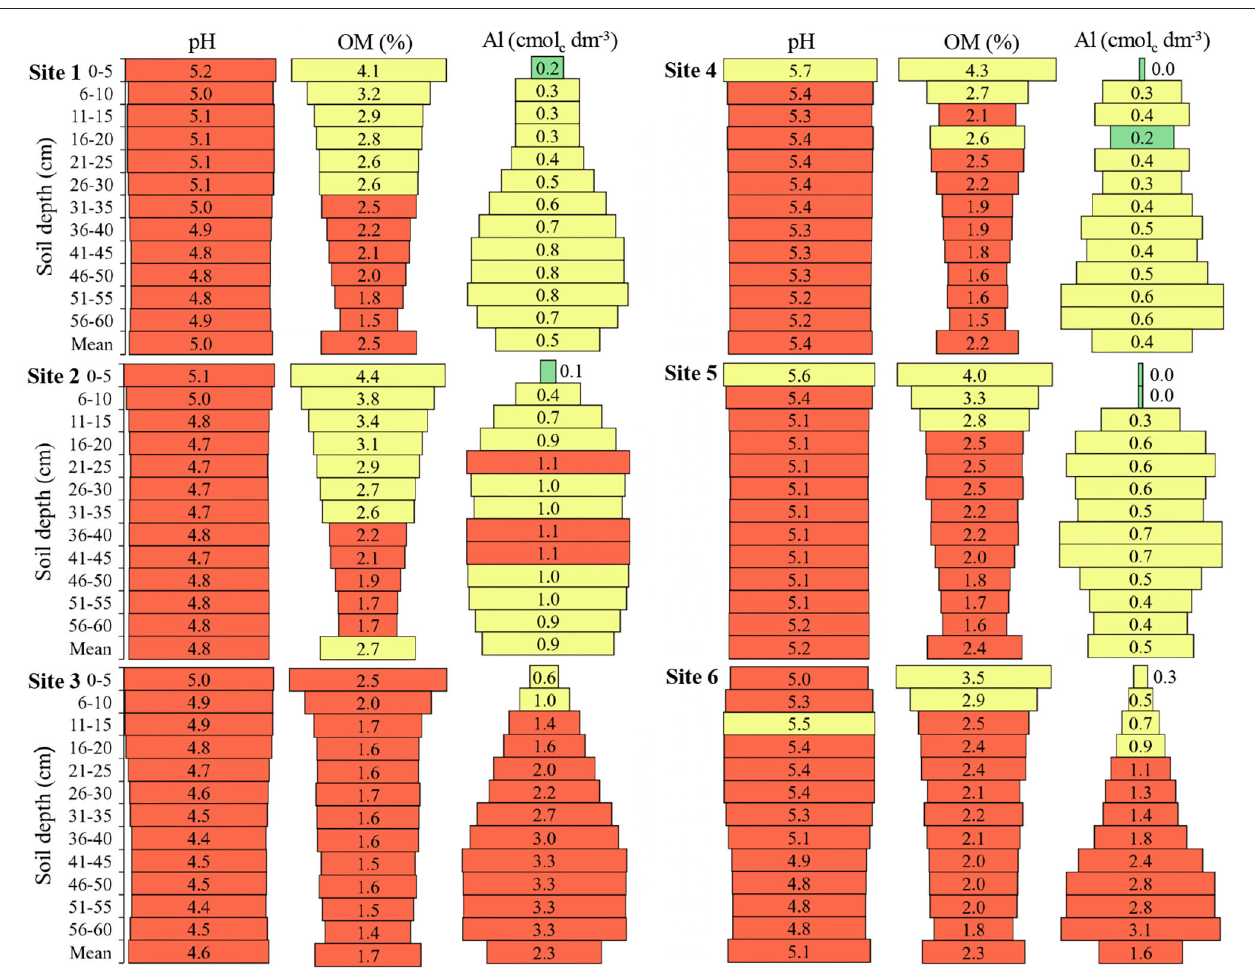
FIGURE 2 | Hydrogenionic potential (pH), organic matter (OM), and aluminum (Al) in the six sites and at different soil depths. Green color: adequate values (pH 6.0–6.5; OM ≥ 6.0; Al ≤ 0.2); Yellow color: intermediate values (pH 5.5–5.9; OM 2.5–6.0; Al 0.3–1.0); Red color: inadequate values (pH ≤ 5.4; OM ≤ 2.4; Al ≥ 1.1) to soils of South of Brazil ( CQFS,